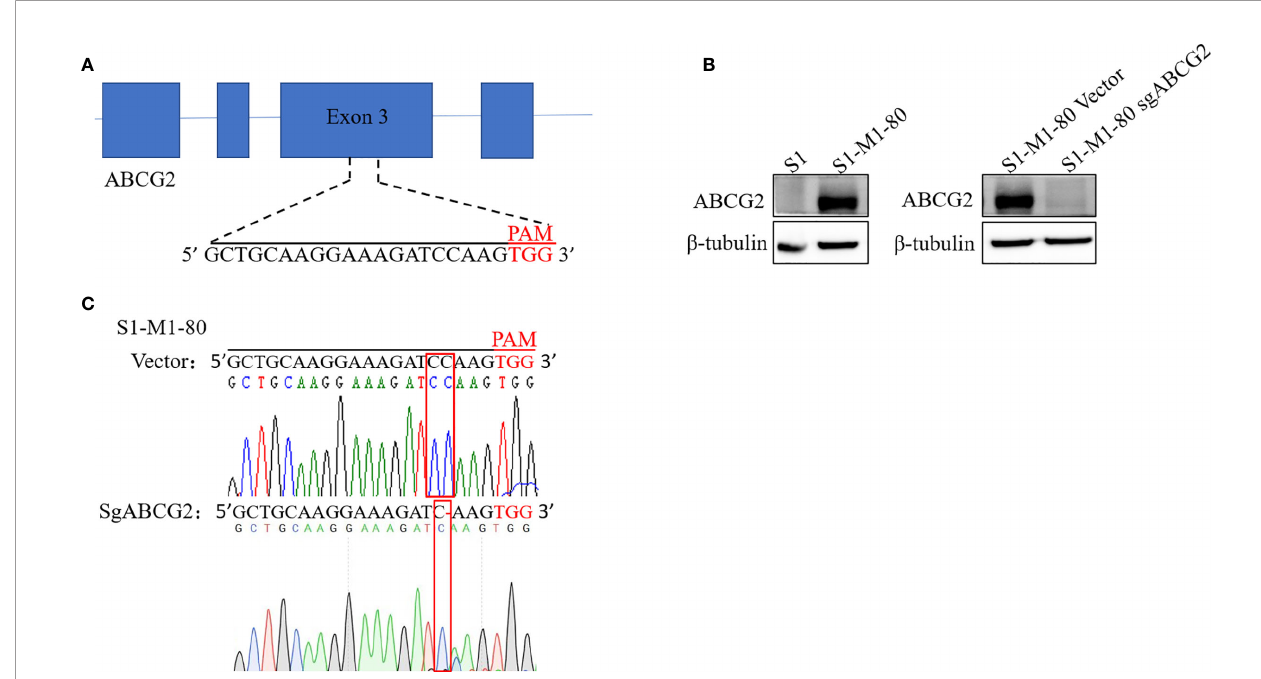
FIGURE 1 | Establishment ABCG2-knockout colorectal cancer cells. A schematic diagram of the designed sgRNA targeting ABCG2 in exon 3 is shown (A) . The protein expression levels of ABCG2 were examined by Western blot, and b -tubulin was used as loading control (B) . The sequencing comparison and original data of S1-M1-80 cells are shown (C)